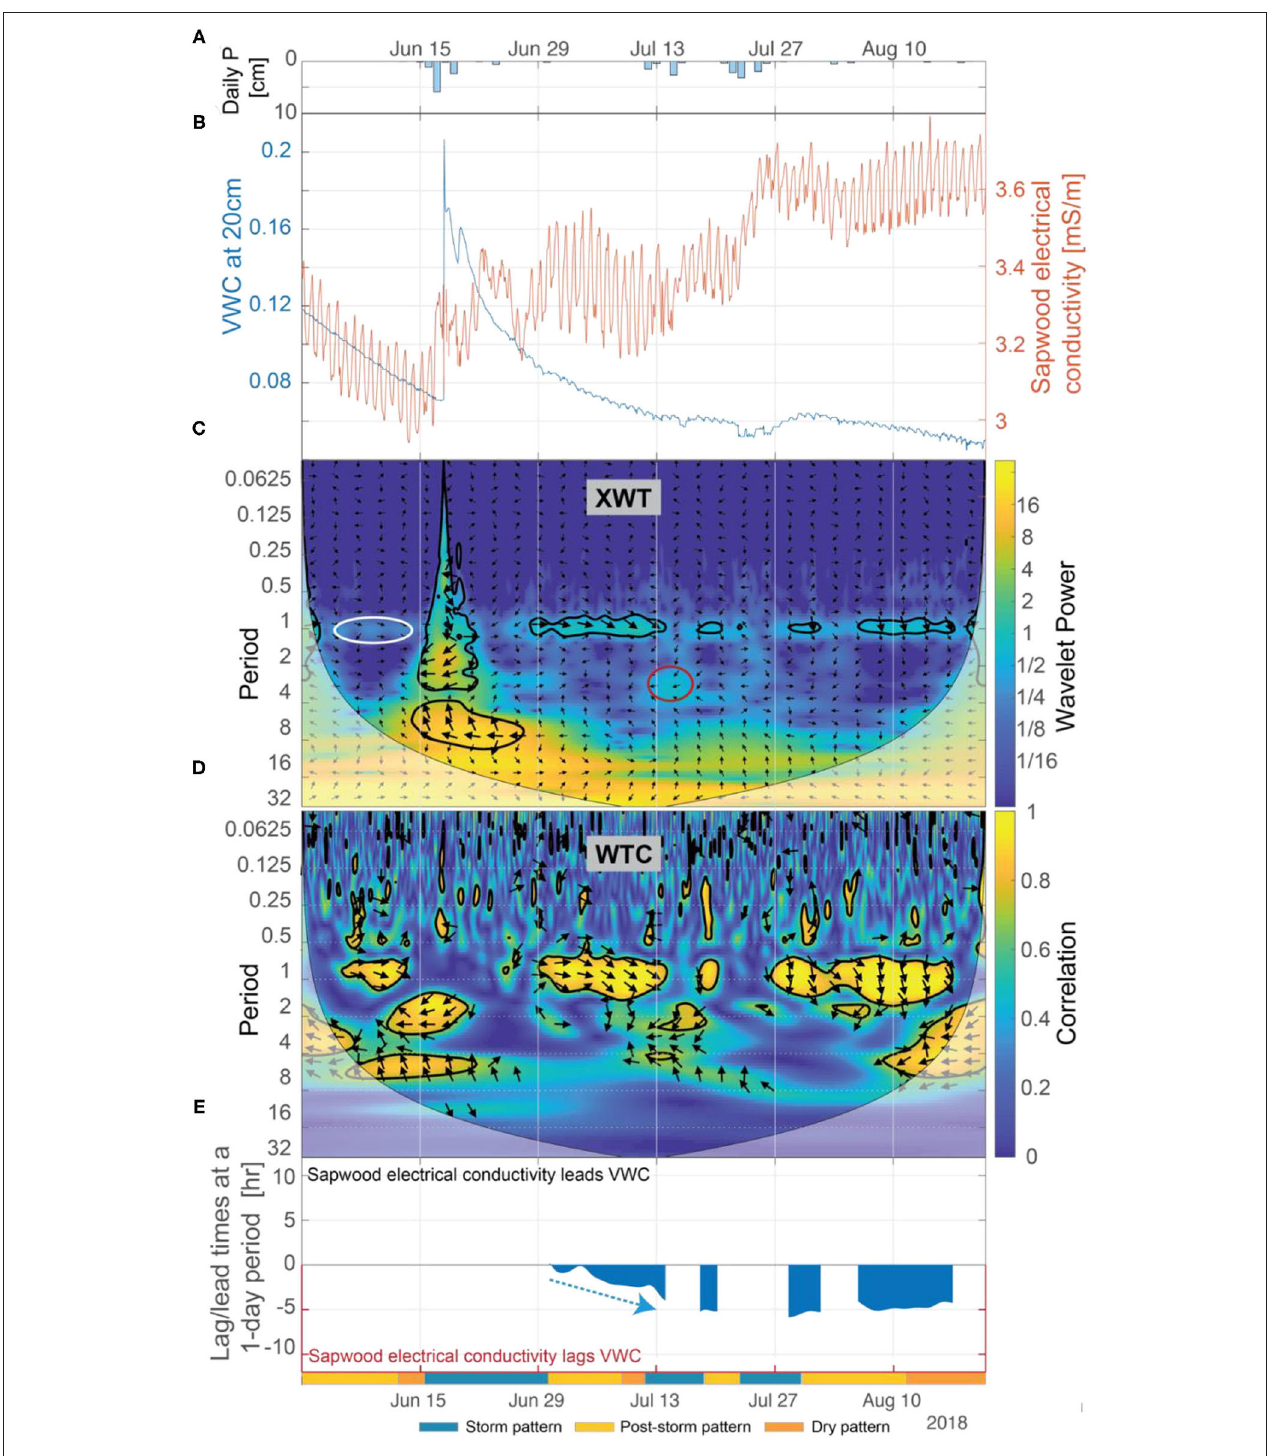
FIGURE 10 | (A) Daily precipitation, (B) soil VWC at 20-cm depth and inverted sapwood electrical conductivity, (C) the XWT of soil VWC and inverted sapwood electrical conductivity, (D) the WTC of soil VWC and inverted sapwood electrical conductivity, and (E) the lead/lag time at a 1-day period between soil VWC and inverted sapwood electrical conductivity. Regions in time-frequency space in the XWT that: were not already identified as significant (black contour lines), had moderately high wavelet power, had periods > 1-day, and where the WTC identified high correlation are outlined with red circles. The white ellipse at ∼ 1-day period highlights a period when the WTC suggests that a 13-day time period of increasing inverted sapwood electrical conductivity between July 14 and July 27 may cause the subsequent (delayed by 6 days as indicated by phase arrows) 12-day period of decreased sapflow occurring between August 2 and 14. Red arrows highlight periods when we hypothesize that progressively dryer conditions increased stomatal regulation, and subsequently decreased lag times. Blue arrows highlight periods when we hypothesize that increased moisture, due to precipitation, decreased stomatal regulation, and subsequently increasing lag times.